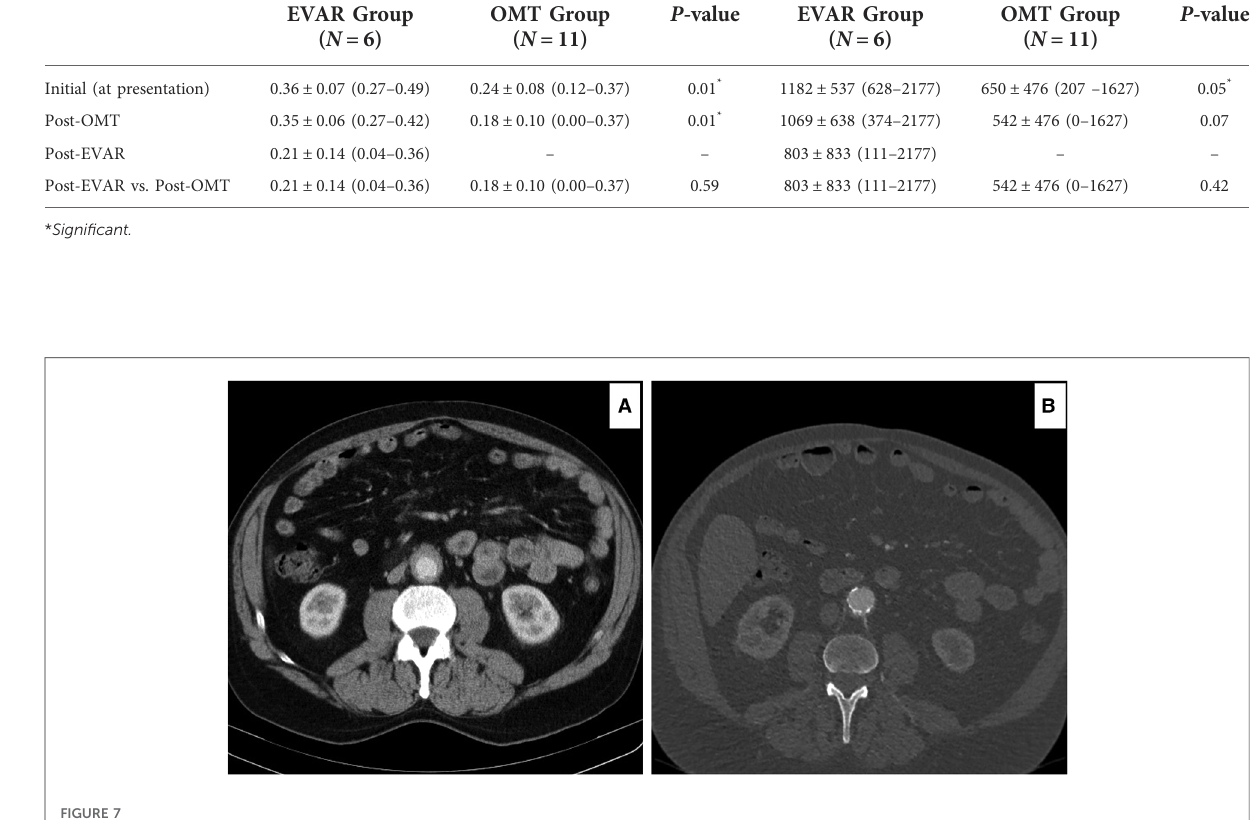
FIGURE 7 Computed tomography angiography (CTA) images showing decrement of the peri-aortic soft tissue enhancements following medical management. ( A ) Initial 4 mm peri-aortic soft tissue enhancement. ( B ) Two years post medical management, the peri-aortic soft tissue enhancement was reduced to 1 mm.